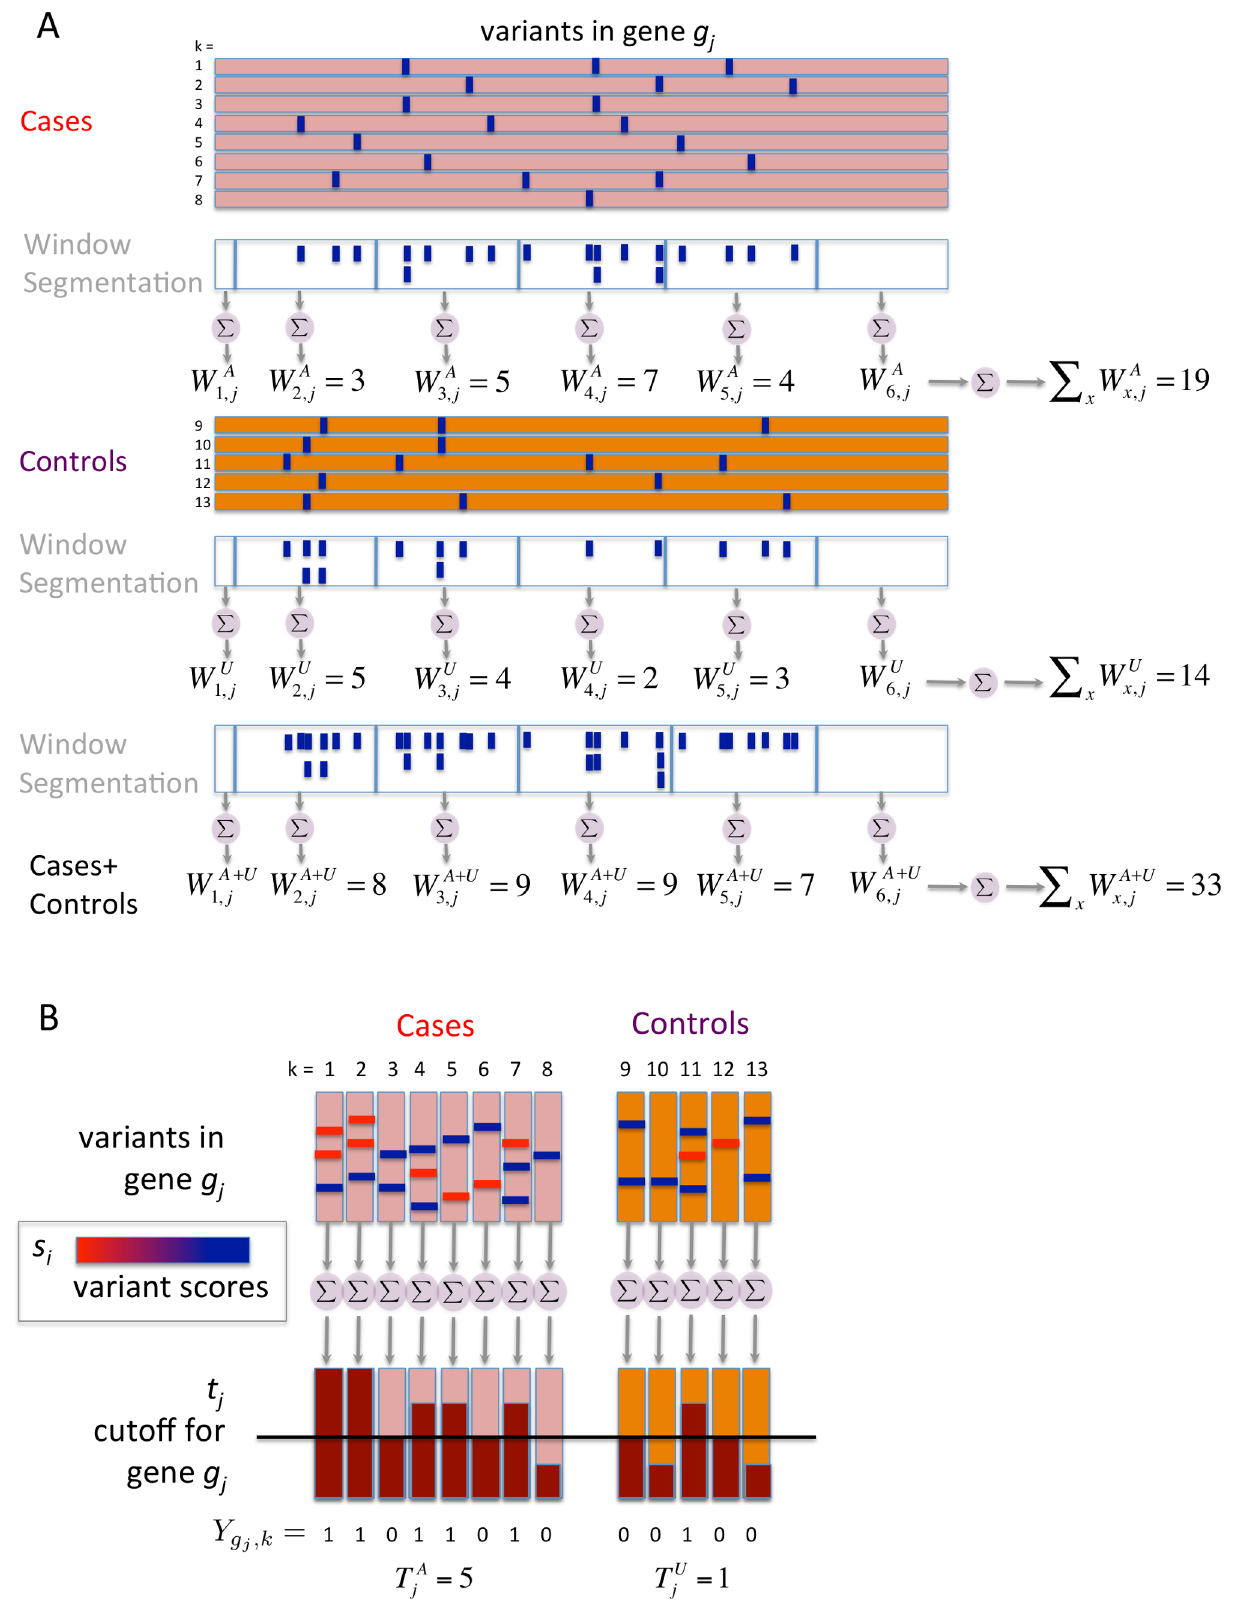
Figure 8. Components of BOMP Hybrid Likelihood Model compared. A. Mutation burden statistic. The Mutation burden statistic uses the , and controls T U . B. Mutation position distribution statistic. Aggregated window mutation counts are calculated for aggregated burden for cases, T A j j cases, W A , controls, W U , and cases and controls combined, W A z U , across x windows. j j j doi:10.1371/journal.pgen.1003224.g008 PLOS Genetics |